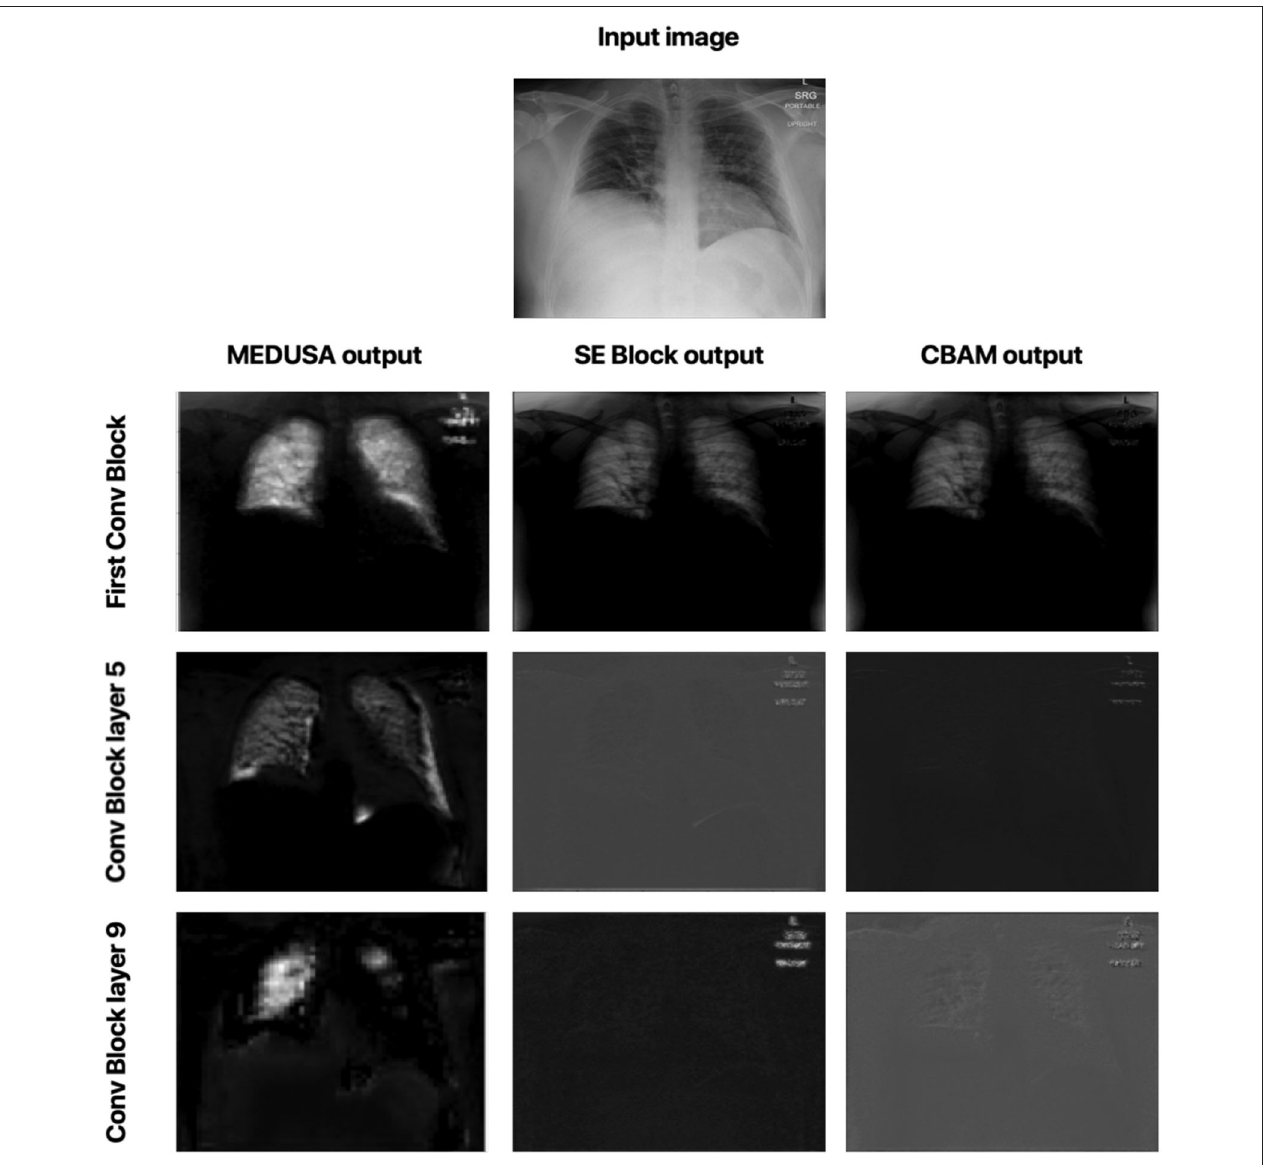
FIGURE 4 | Comparison between attention-enforced outputs at different convolutional blocks when using CBAM, SE Block, and MEDUSA self-attention mechanisms. Each row demonstrates the results of the attention mechanisms on a different layer of the ResNet-50 network architecture.